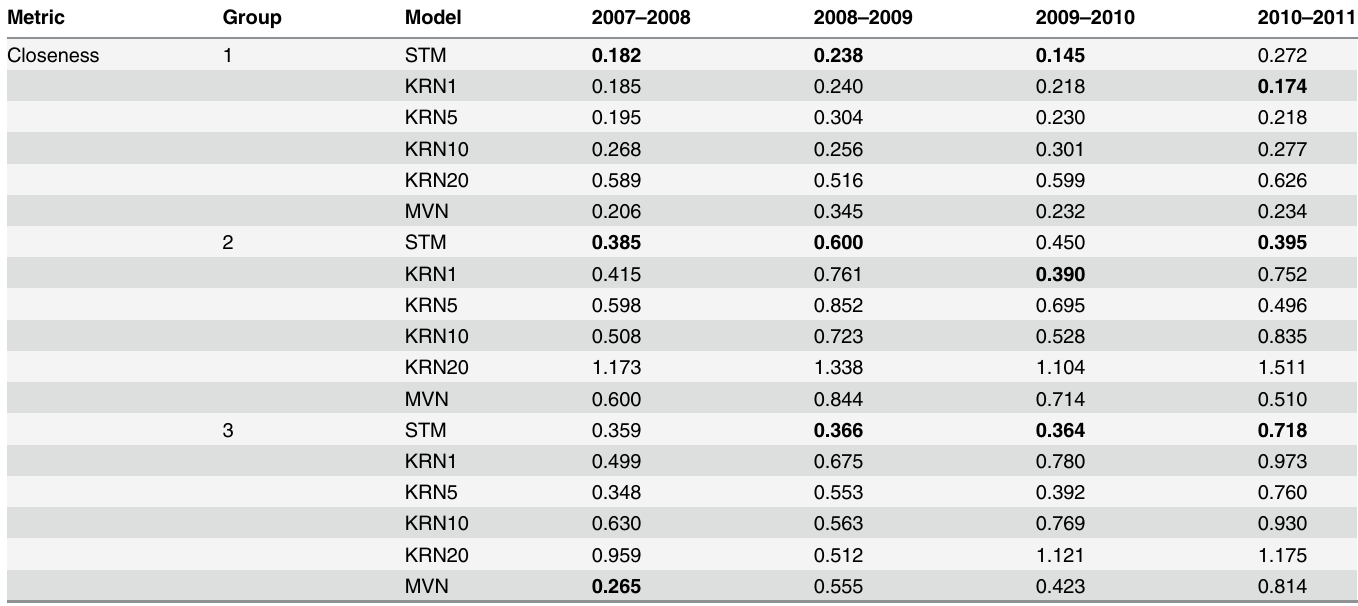
Table 3. The mean difference in the closeness measure between the simulations and the data for the year. The numbers in bold indicate the best mea- sure among the three models for each year. Metric Group